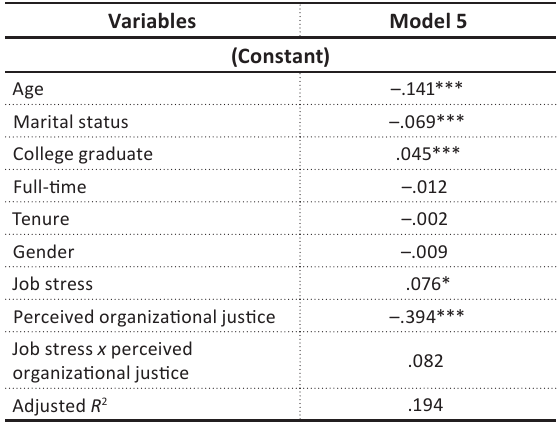
Table 3. Results of a regression analysis of